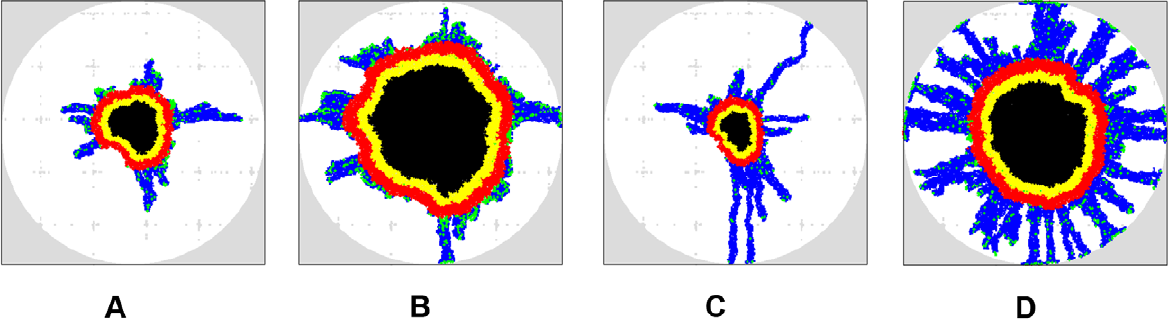
Figure 10. Simulated growing tumors in the ECM having a sinusoidal-like density distribution with different cellular motilities ( m ~ 1 , 3 ). The mutation rate is c ~ 0 : 05 and ECM degradation ability is x ~ 0 : 9 . (a) Growing tumor with cell motility m ~ 1 on day 80. (b) Growing tumor with cell motility m ~ 1 on day 120. (c) Growing tumor with cell motility m ~ 3 on day 80. (d) Growing tumor with cell motility m ~ 3 on day 120. Note that both the primary tumor and invasive pattern in the two cases are significantly affected by the ECM heterogeneity, i.e., the tumors are highly anisotropic in shape and the invasive branches clearly favor two orthogonal directions associated with low ECM densities in the early growth stages. Although we only consider spherical growth-permitting regions here, our tumor-growth simulations can incorporate growth-permitting regions with arbitrary shapes.